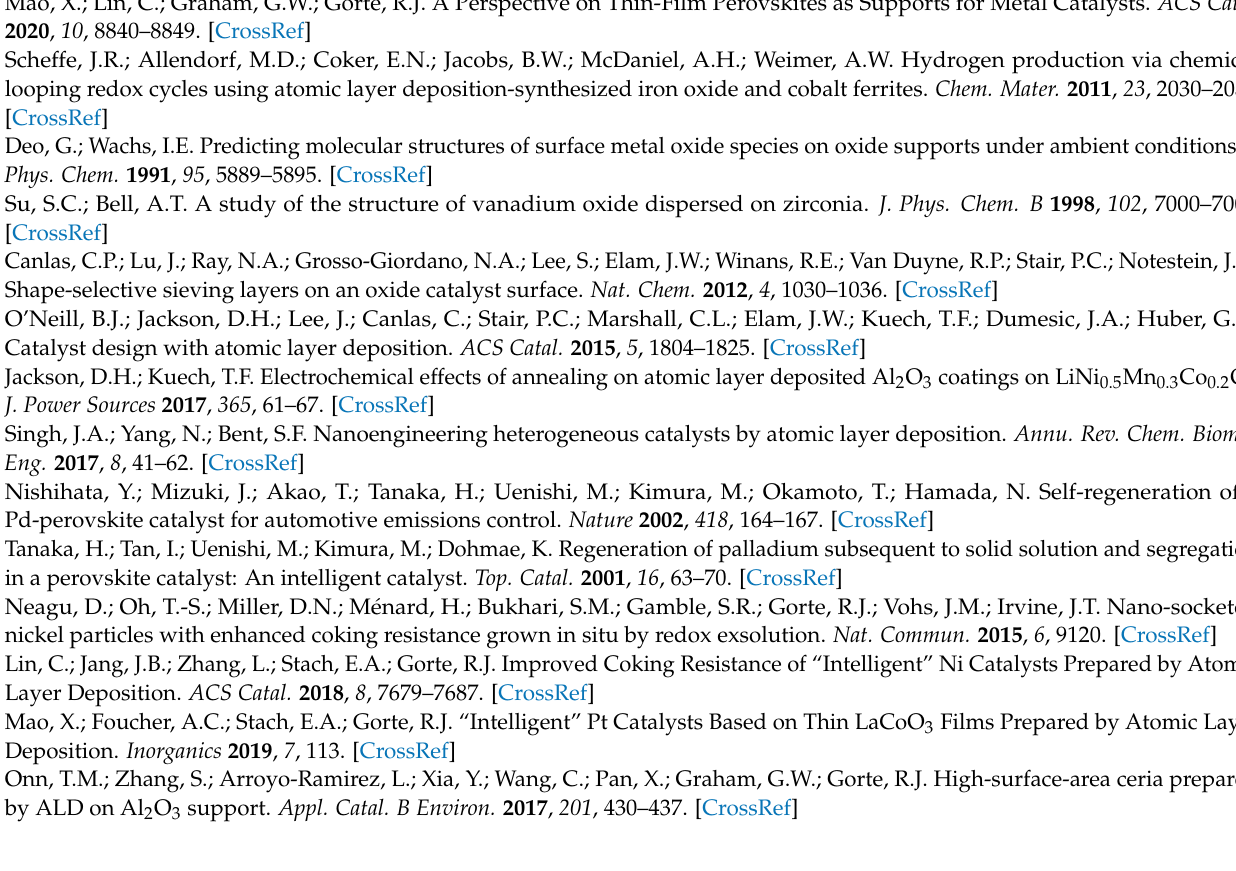
by the dashed red frame; (e) HR-TEM of the sample, image acquired from the orange framed region, Figure S2: XRD patterns of CaTiO 3 deposited on SiO 2 , the black line denotes bare SiO 2 and the red line denotes CaTiO 3 /SiO 2 , Figure S3: Growth rate of CaO, TiO 2 on γ -Al 2 O 3 as a function of ALD cycles. (a) CaO; (b) TiO 2 , Figure S4: Growth rate of CaO, TiO 2 on SiO 2 as a function of ALD cycles. (a) CaO; (b) TiO 2 , Table S1: Lattice perimeters and d-spacing values of standard CaTiO 3 crystal